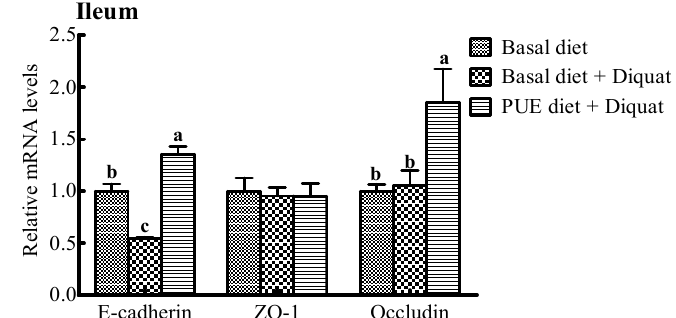
Figure 2. The relative mRNA levels of E-cadherin, zonula occludens (ZO-1) and occludin in the jejunum and ileum of the piglets. The mRNA expressions were expressed relative to the values of the piglets on the basal diet treatment. Data are expressed as means ± SEM, n = 8. a,b Values with different lowercase letters are different ( p < 0.05).